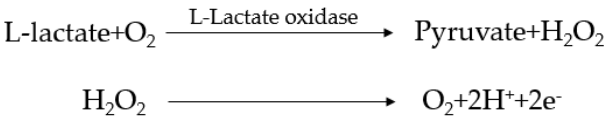
Figure 6. The signal generation scheme.